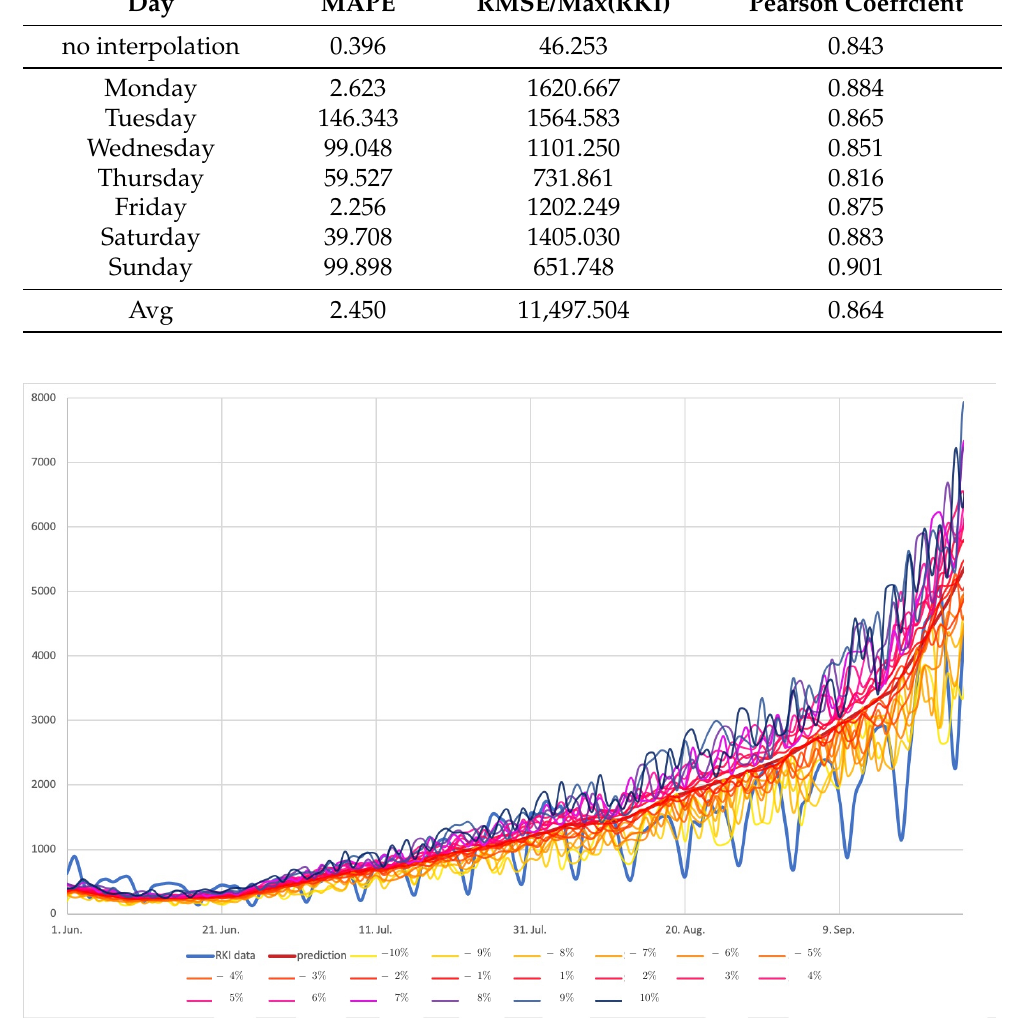
Figure 12. Sensitivity of the model towards the perturbations of the